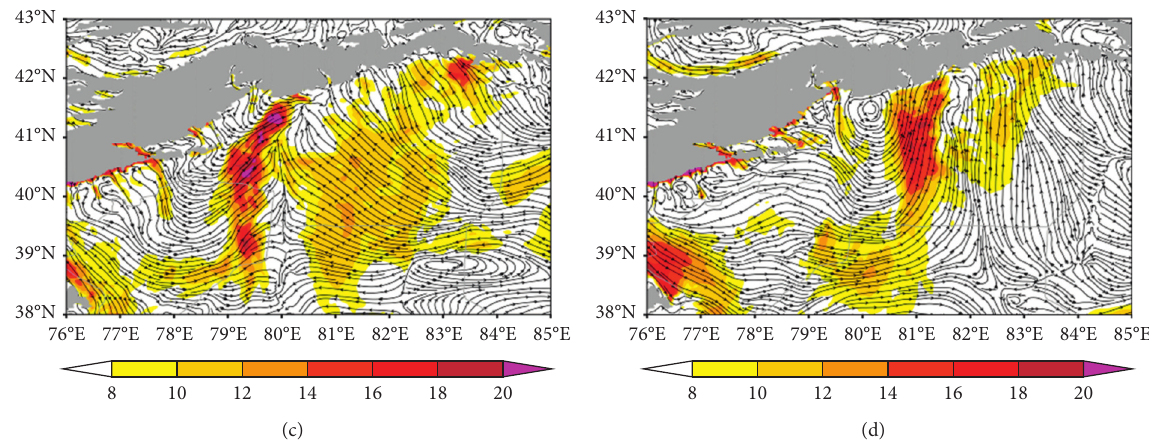
Figure 6: The 700hPa flow field (streamline) and high wind speed area (colored and shaded, unit: m · s − 1 ; gray shading represents the terrain of the Tianshan Mountains above 3000m). (a) Initiation stage at 12:00 on July 31, (b) development stage at 16:00 on July 31, (c) maturity stage at 17:30 on July 31, and (d) extinction stage at 22:00 on July 31,